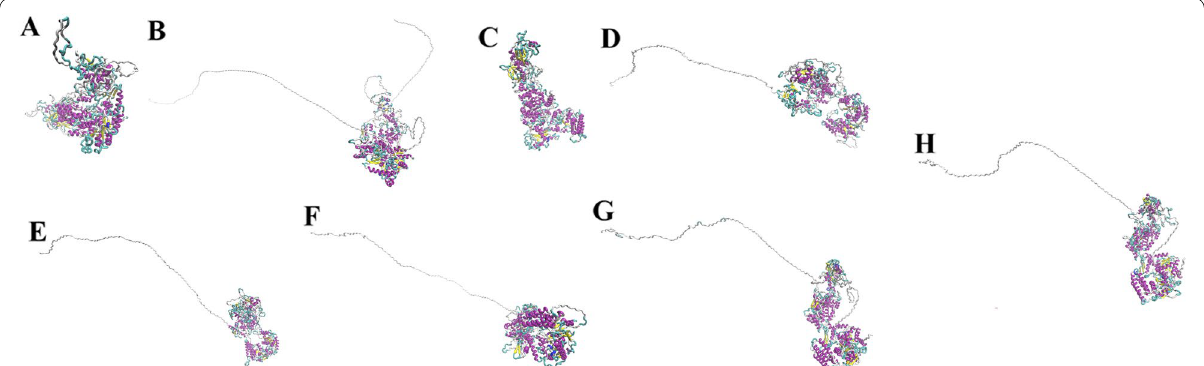
Fig. 4 The presentation of predicted structure for DCL proteins encoded in A. thaliana and A. protothecoides by visualizing the predicted PDB files in the VMD protein visualization program. The proteins structure was modeled by searching their sequence in the HHpred search tool throughout the PDB and modeled by the MODELLER software. A : A._protothecoides DCL protein. B : A. thaliana DCL1 AE202177.1. C : A. thaliana DCL2 AEE73925.1. D : A. thaliana DCL3 AEE77842.1. E : A. thaliana DCL3 NP 001154662.2. F : A. thaliana DCL4 AED92830. G : A. thaliana DCL4 NP 001190348. H : A. thaliana DCL4